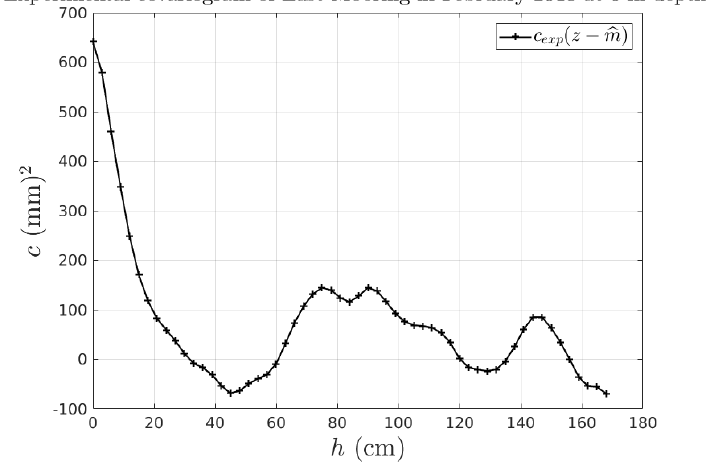
Figure 12. Experimental covariogram of a dense sub-trajectory.